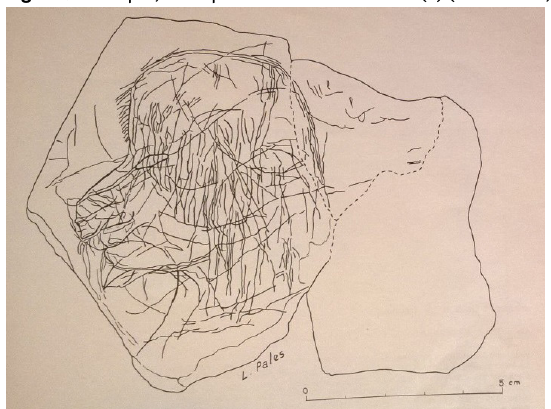
Figure 10. Group α, examples of Hand α2: Obs. 8 (from Pales, 1976).